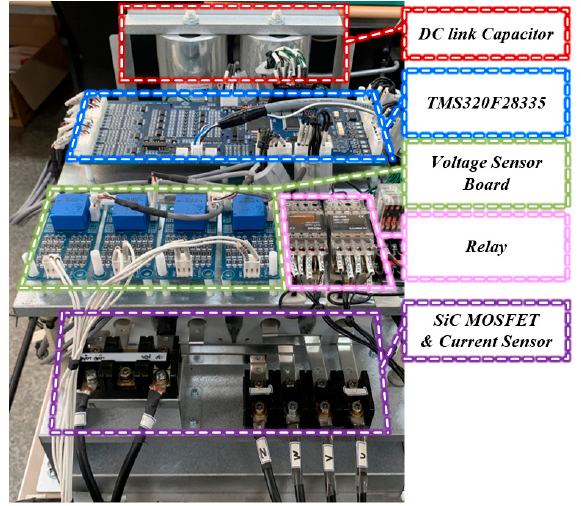
Figure 17. Configuration of the 10 kW class ILC hardware set.